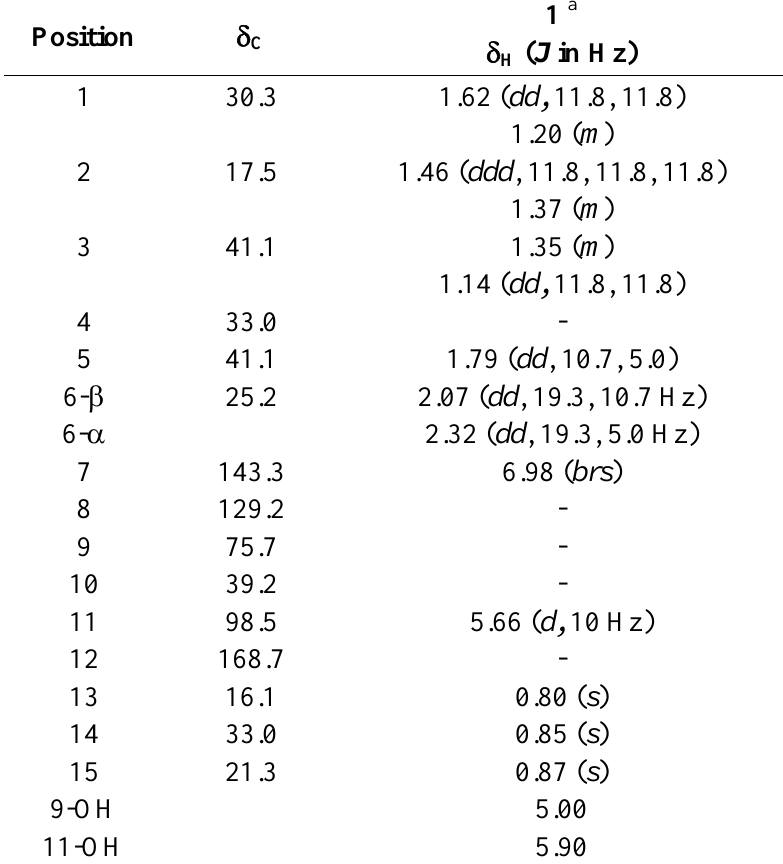
Table 1. 13 C- and 1 H-NMR spectral data of compounds 1 ( δ in ppm, J in